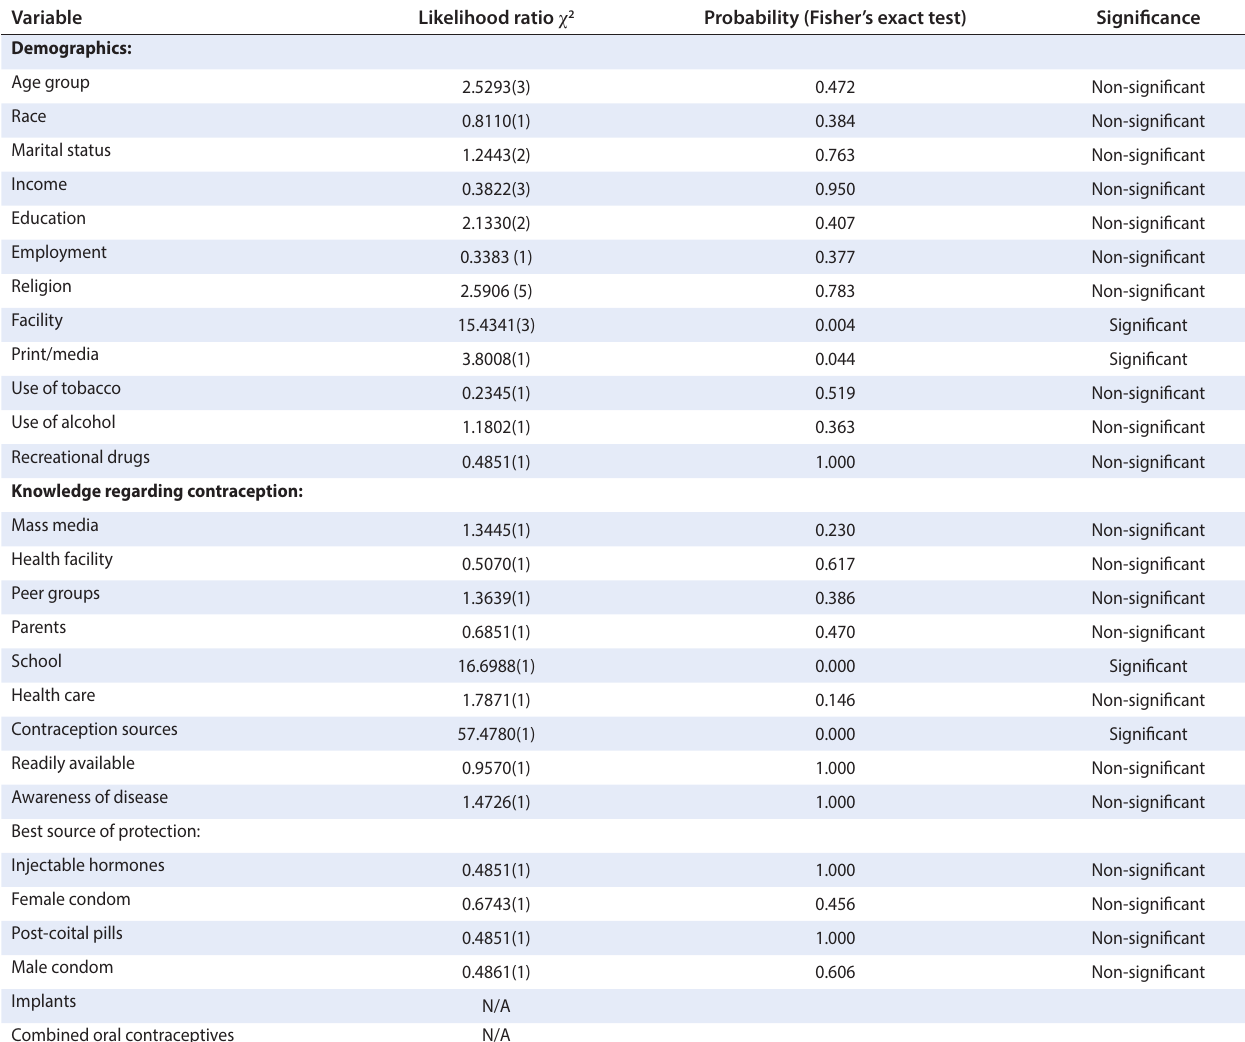
Table 5: Other important